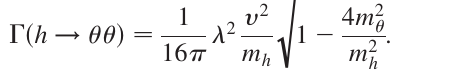
FIG. 1. The pNGB coupling to the sterile neutrino, g , versus ¼ 0 : 05 eV and , in GeV. We have fixed m the pNGB mass, m (cid:1) (cid:3) k ¼ 1 . The upper (lower) green shaded region is excluded by requiring the SSB scale f to be larger than 1 TeV (smaller than the Planck scale). The four dotted lines correspond to these constant values of the sterile-neutrino mass, from top to bottom: ¼ 10 2 , 10 6 , 10 10 , 10 14 GeV . The thin diagonal (vertical) m N